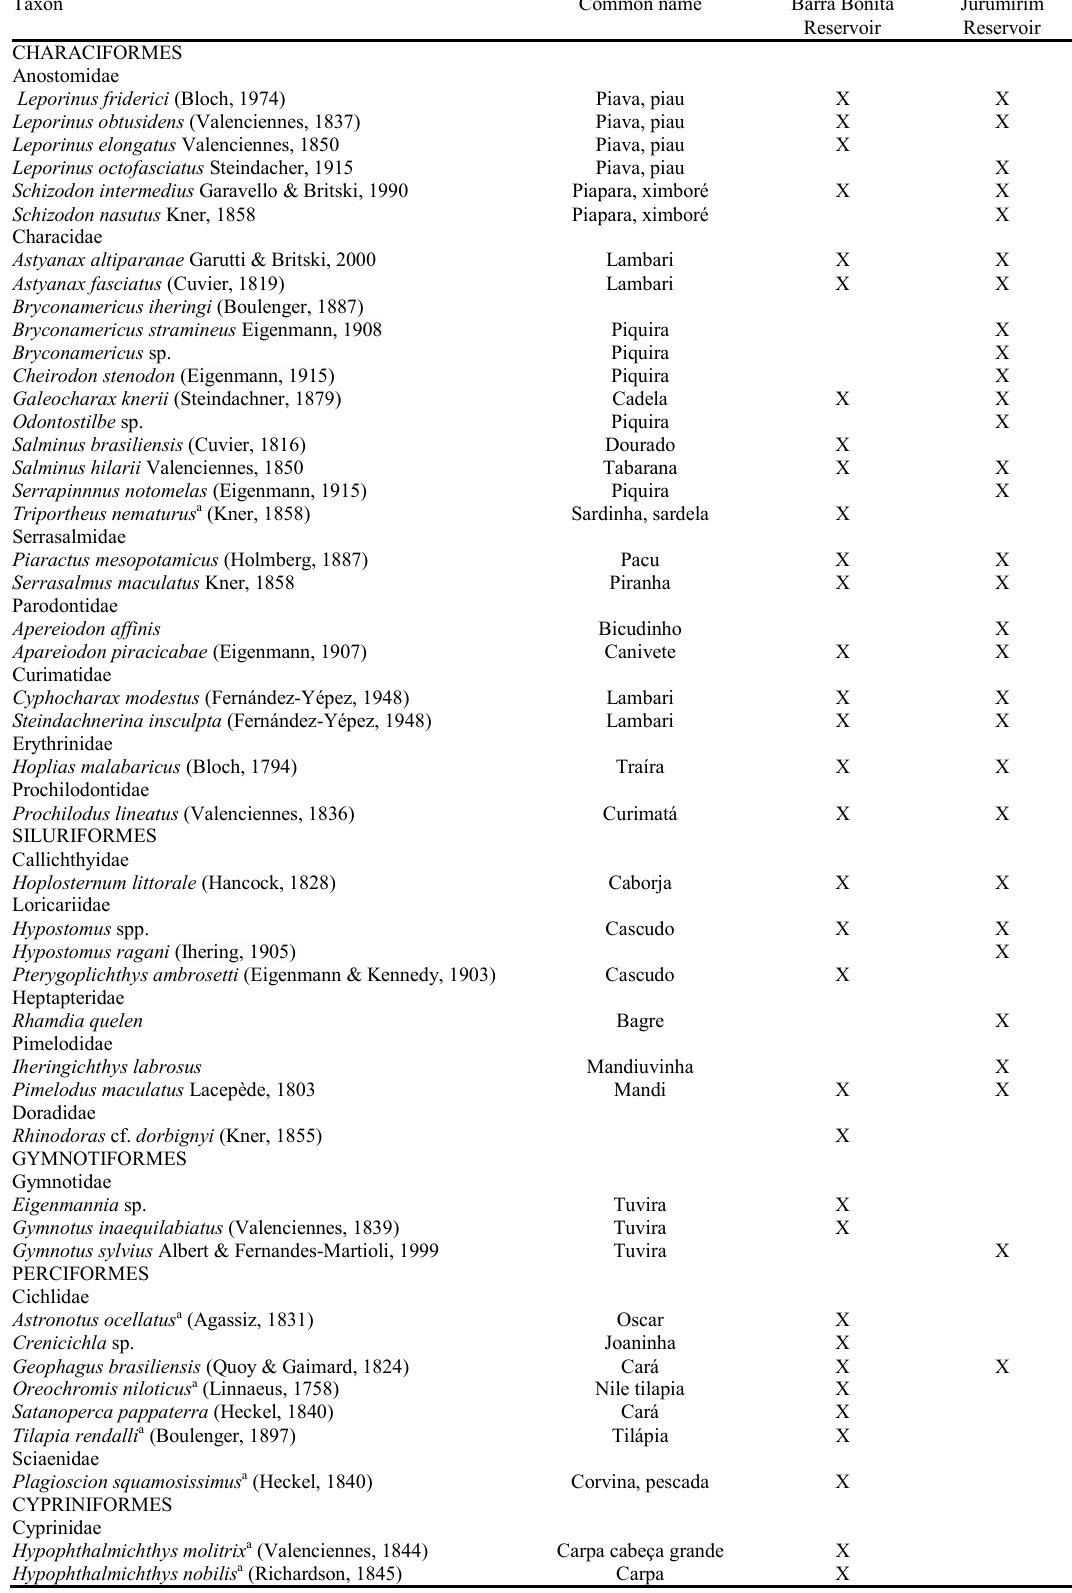
Table 2. List of fish species caught by artisanal fisheries in the Barra Bonita (Tietê River) and Jurumirim (Parnapanema River) reservoirs during the study period. a Non-native